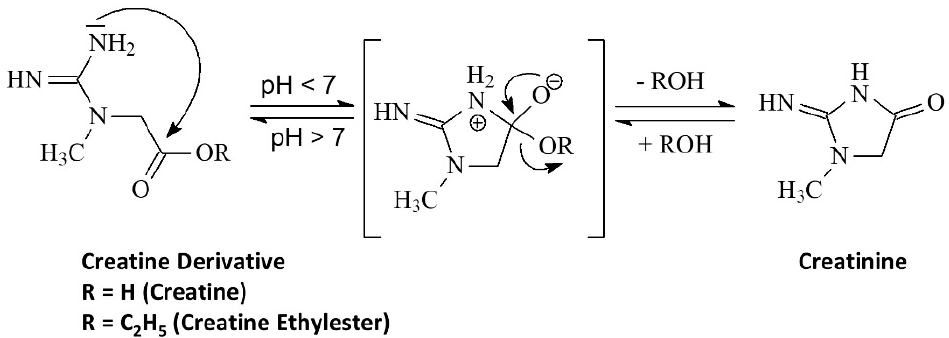
Figure 9. Degradation of creatine ethyl ester to creatinine. Adapted from Jäger et al. [25].